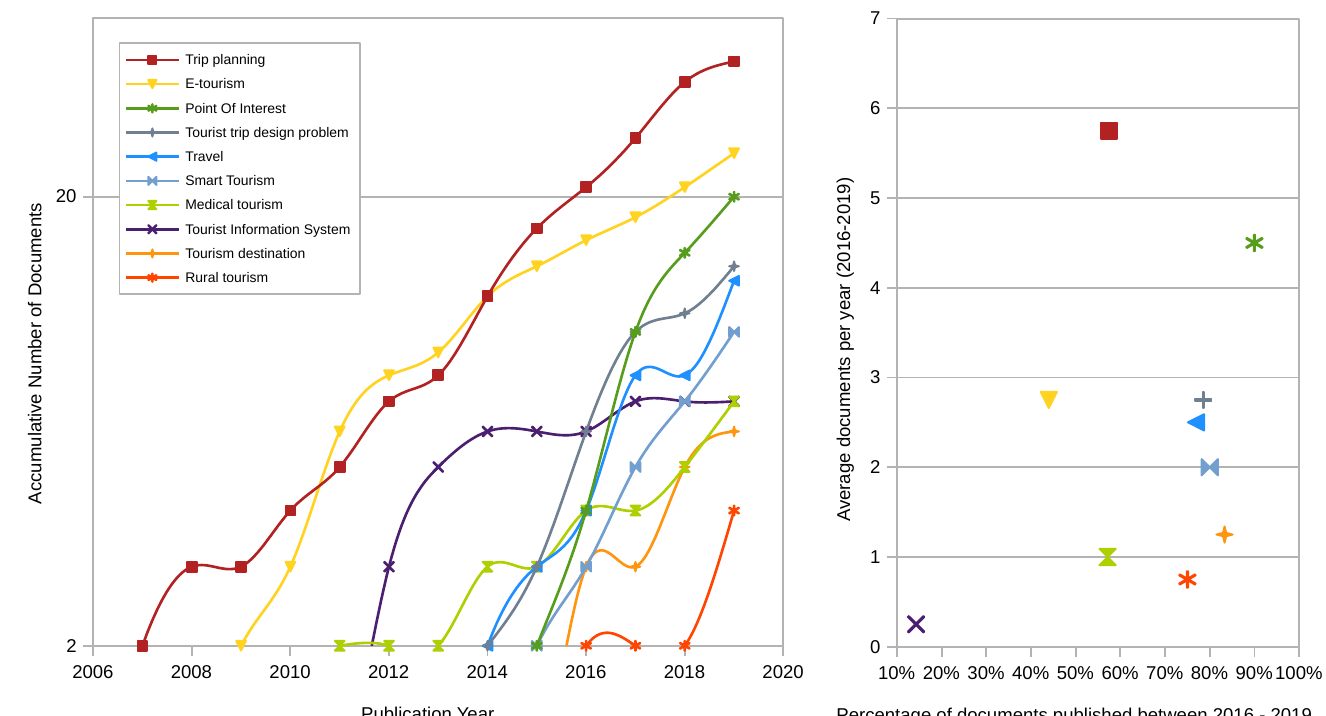
Figure 5. Point of Interest, tourist trip design problem, travel, and smart tourism in tourist recommender